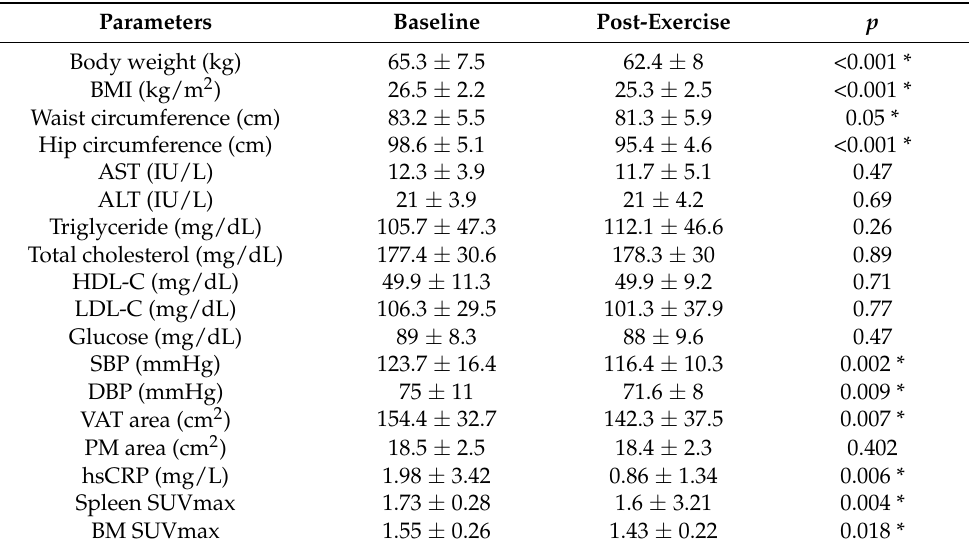
Table 2. Comparison of clinical parameters between baseline and post-exercise.